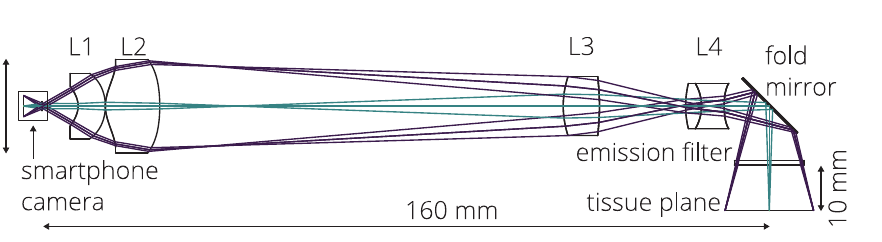
Fig 3. Layout of the intraoral probe optical design.